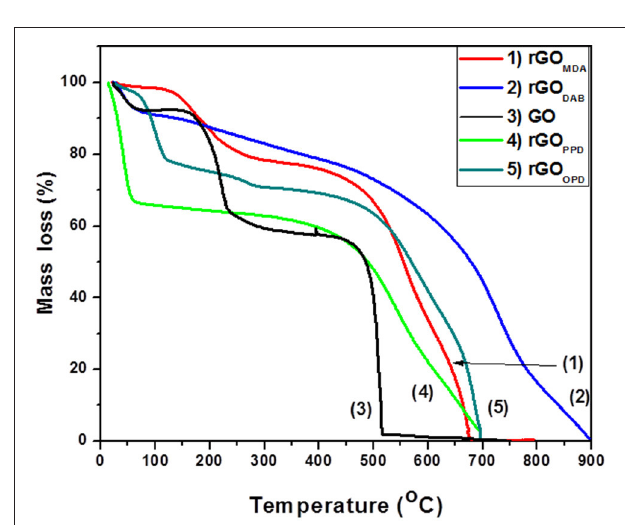
FIGURE 9 | TG analysis of aerogels with aromatic diamines and